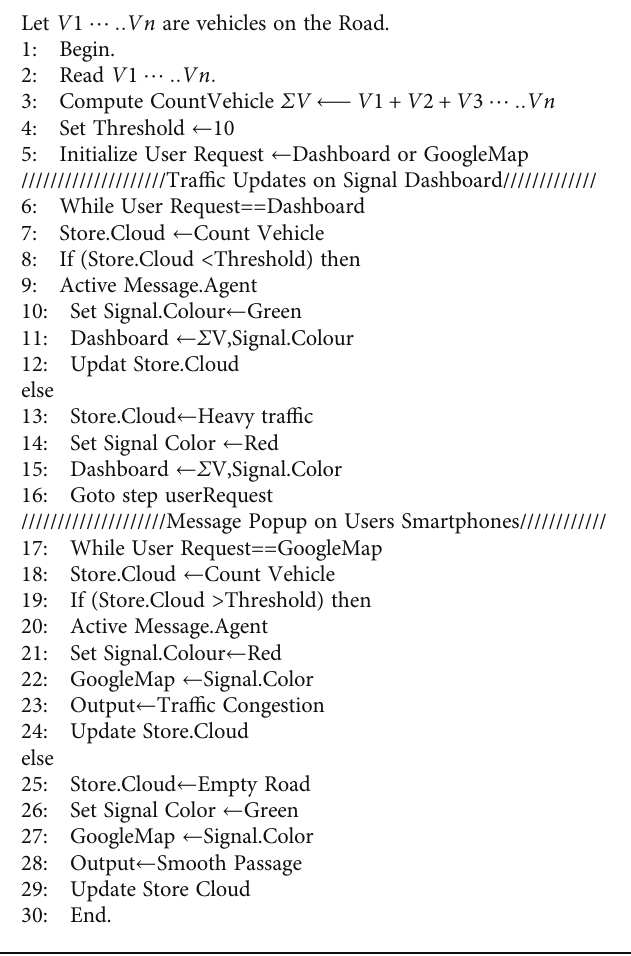
Algorithm 1: Proposed algorithm.